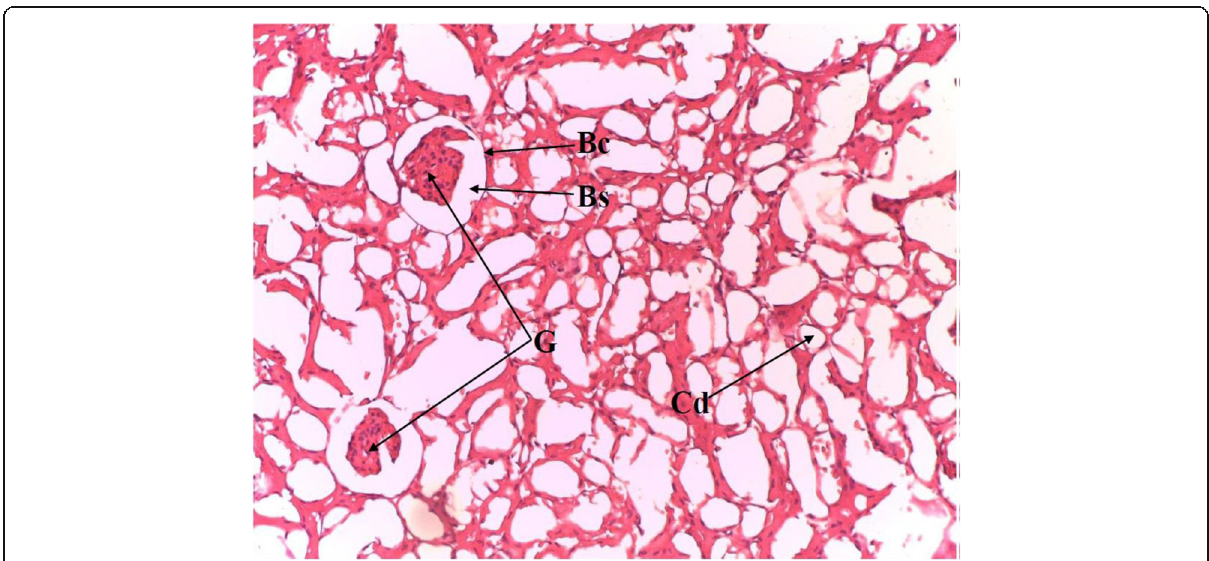
Fig. 10 Photomicrograph of kidney section of rat administered ethanolic leaves ’ extract of P. guineense (100 mg/kg bw) showing normal glomerulus (G), collecting ducts (Cd) and Bowman ’ s capsule (Bc). The Bowman ’ s spaces (Bs) are mildly enlarged